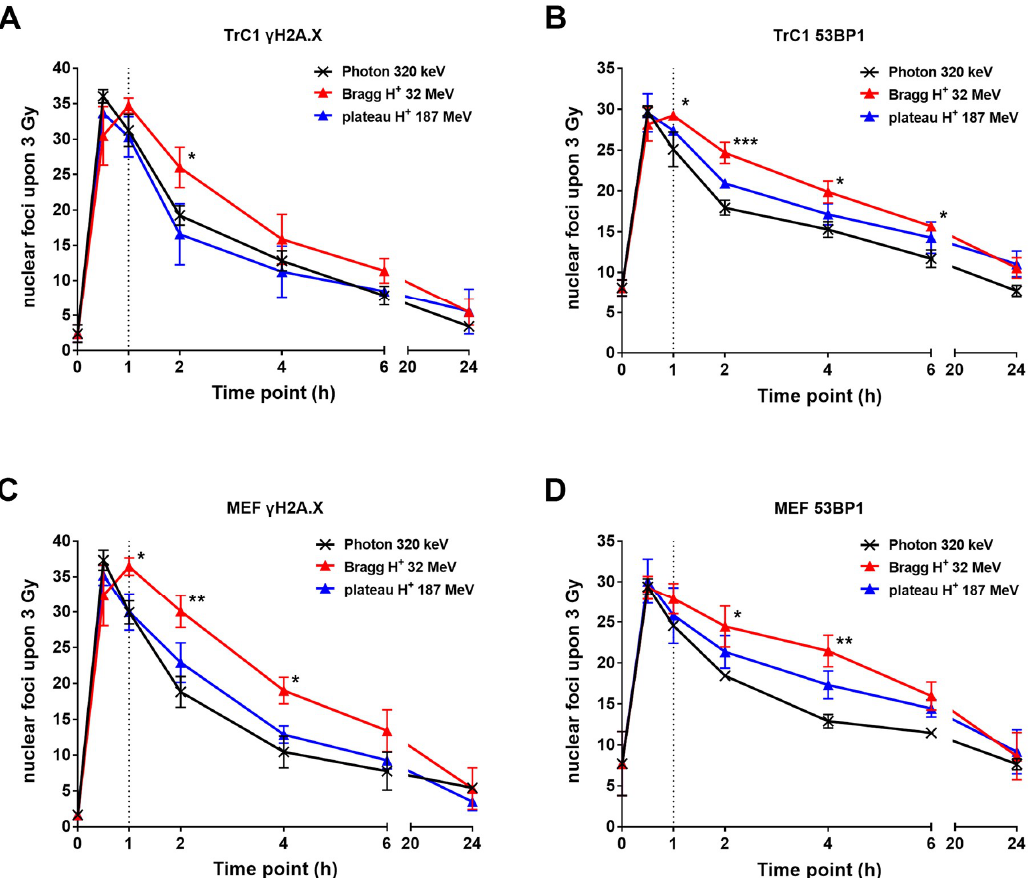
Figure 2. Formation and resolution of nuclear γ H2A.X and 53BP1 foci after irradiation with X-ray photons or protons. Prostate cancer cells (TrC1) and murine embryonal fibroblasts (MEF) were exposed to 3 Gy irradiation with X-ray, plateau protons, and Bragg-peak protons. Cells were fixed at the indicated timepoints after irradiation for immunofluorescence analysis via γH2A.X ( A , C ) and 53BP1 ( B , D ). The γH2A.X and 53BP1 foci were analyzed with Focinator v2-22 software. The dotted line marks the 1-h timepoint. Data show means ± SD ( n = 3, each 50 nuclei). *p < 0.05, **p < 0.01, ***p < 0.001; multiple t -tests.